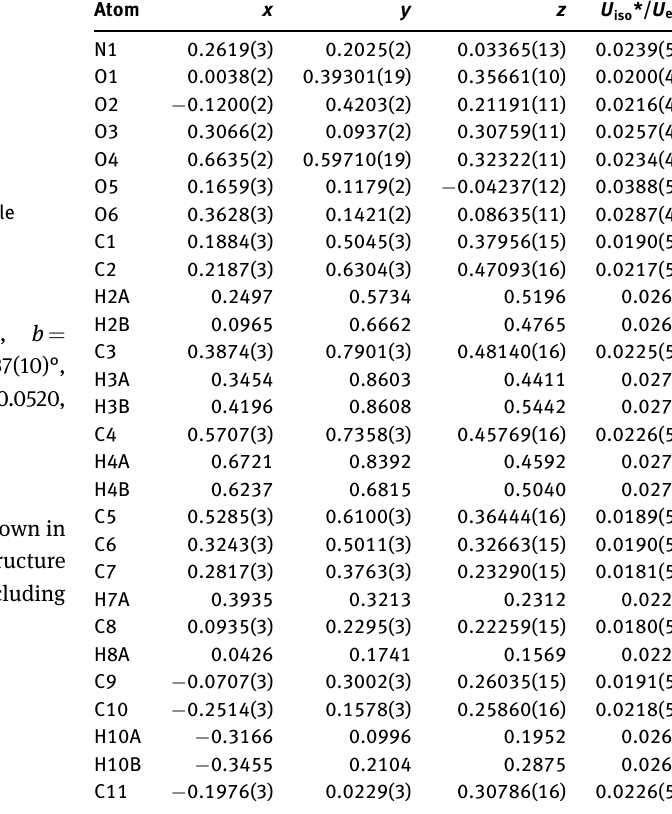
Table 2: Fractional atomic coordinates and isotropic or equivalent isotropic displacement parameters (Å 2